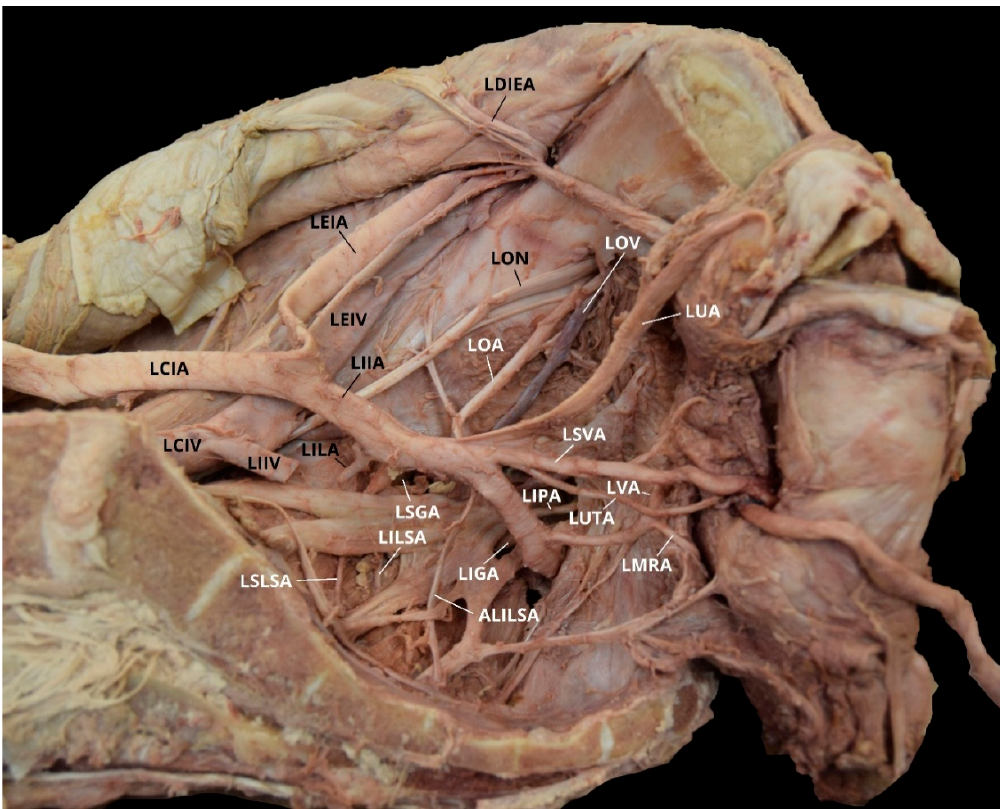
Figure 10. Facilitated display highlighting the left internal iliac artery branches for Case 6. ALILSA = Accessory Left Inferior Lateral Sacral Artery; LCIA = Left Common Iliac Artery; LCIV = Left Common Iliac Vein; LDIEA = Left Deep Inferior Epigastric Artery; LEIA = Left External Iliac Artery; LEIV = Left External Iliac Vein; LIIA = Left Internal Iliac Artery; LIGA = Left Inferior Gluteal Artery; LIIV = Left Internal Iliac Vein; LILA = Left Iliolumbar Artery; LILSA = Left Inferior Lateral Sacral Artery; LIPA = Left Internal Pudendal Artery; LMRA = Left Middle Rectal Artery; LOA = Left Obturator Artery; LON = Left Obturator Nerve; LOV = Left Obturator Vein; LSGA = Left Superior Gluteal Artery; LSLSA = Left Superior Lateral Sacral Artery; LSVA = Left Superior Vesical Artery; LUA = Left Umbilical Artery; LUTA = Left Uterine Artery; LVA = Left Vaginal Artery.